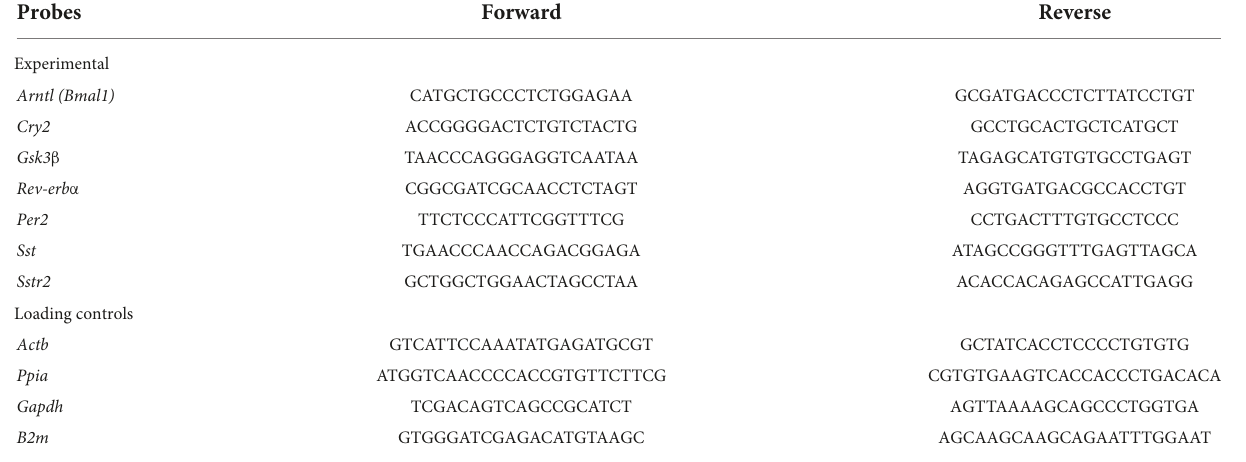
TABLE 1 Table of primer